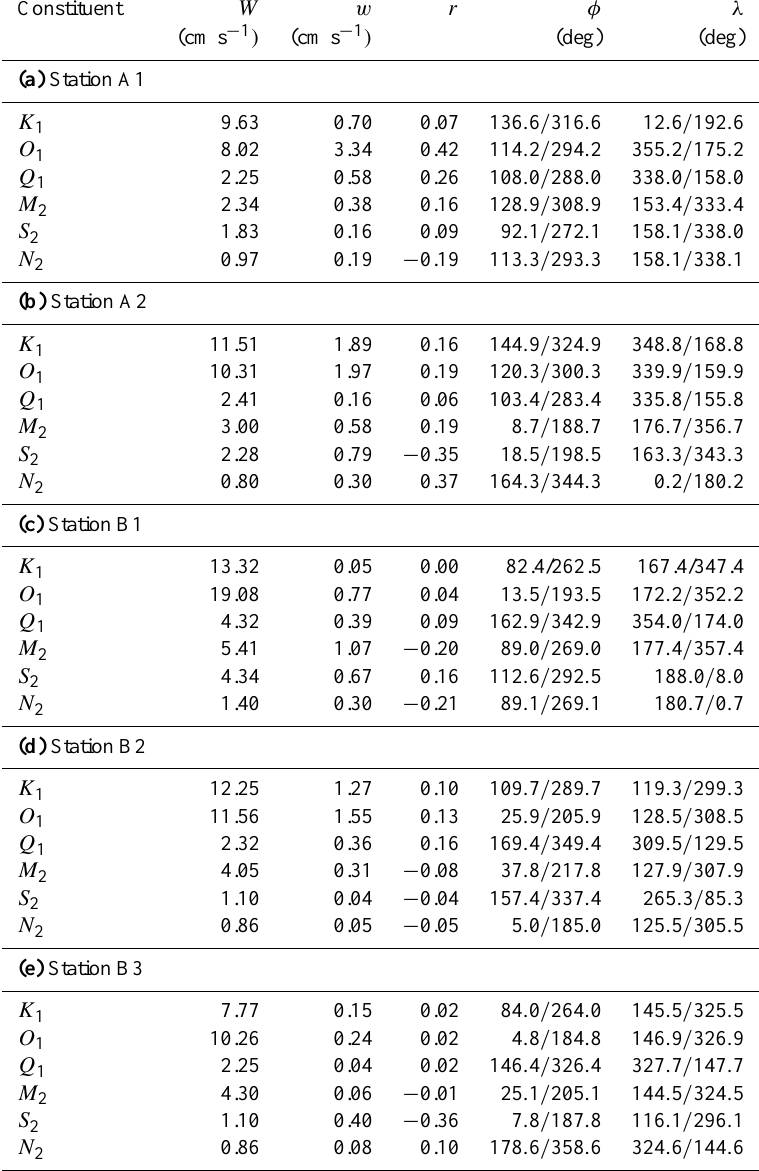
Table 4. Vertically averaged tidal current